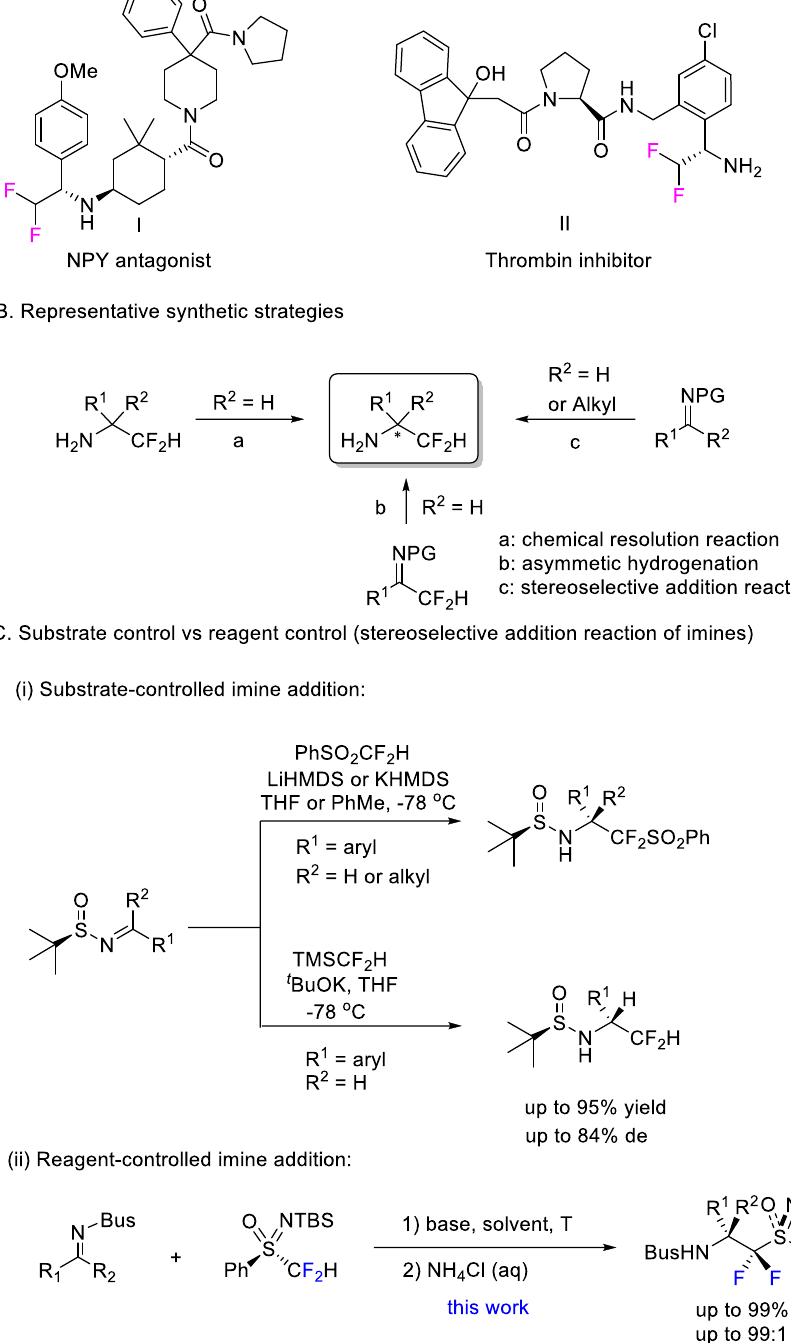
Figure 1. Examples of biologically active α -difluoromethyl amines and state-of-the-art methods: ( A ) representative bioactive molecules containing α -difluoromethyl amine; ( B ) representative synthetic strategies; ( C ) substrate- and reagent-controlled strategies.